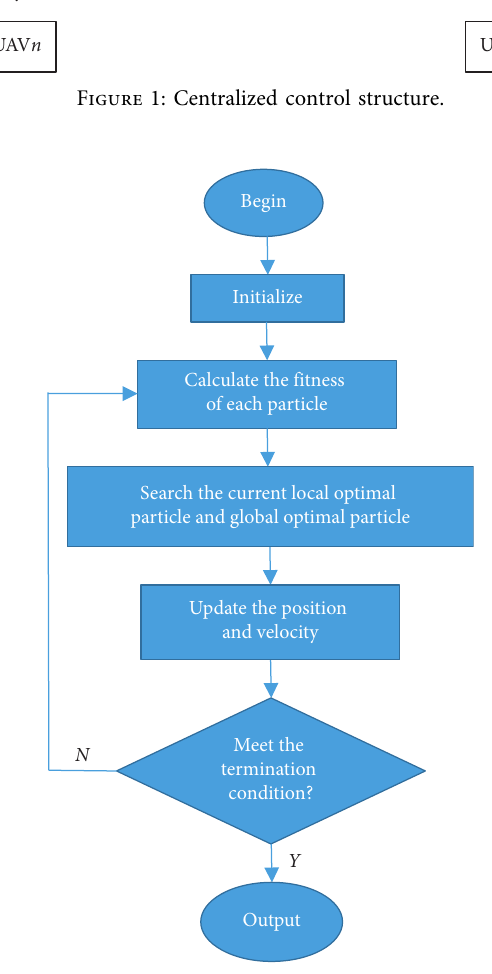
Figure 2: Flow chart of